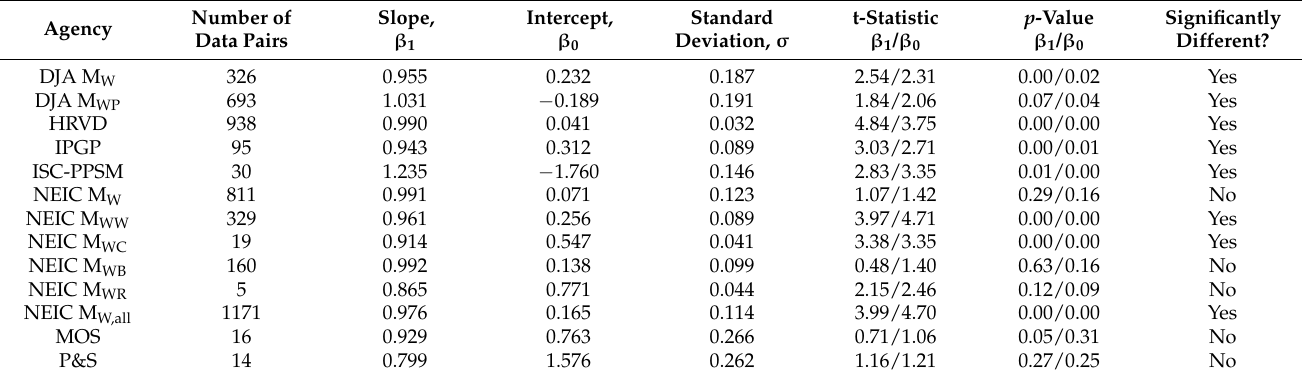
Table 3. Hypothesis testing results against a M W pool from GCMT, ISC-GEM, and EVBIB for the Indonesian catalog. Significance level α =